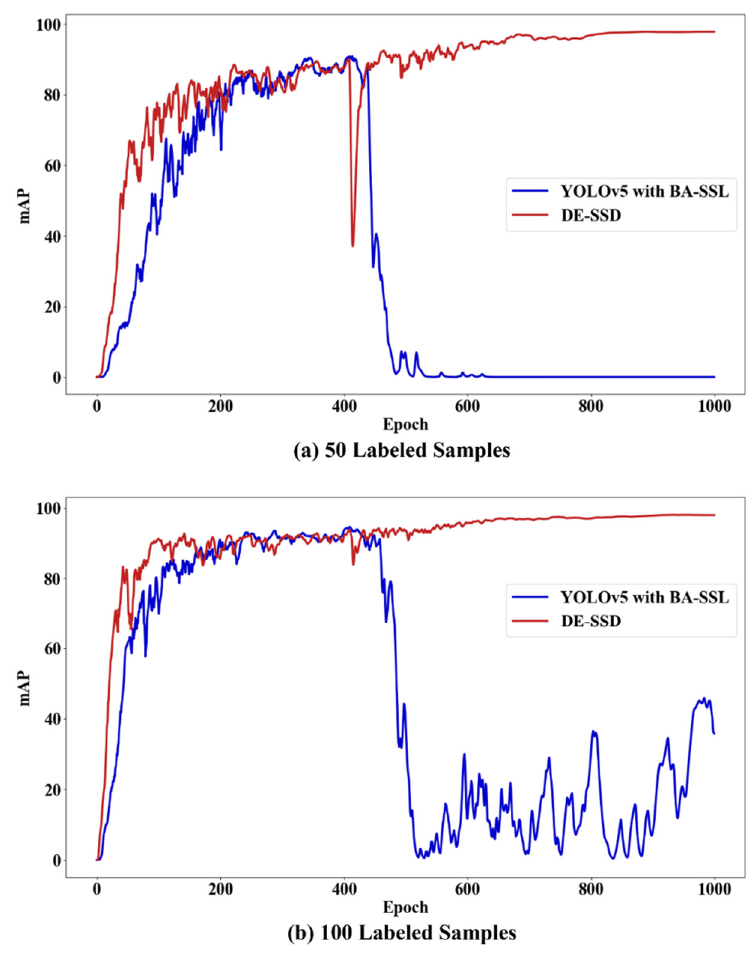
Figure 9. mAP of each epoch while training the detection model. ( a ) Trained with 50 labeled samples. ( b ) Trained with 100 labeled samples. These models are trained with all unlabeled samples.